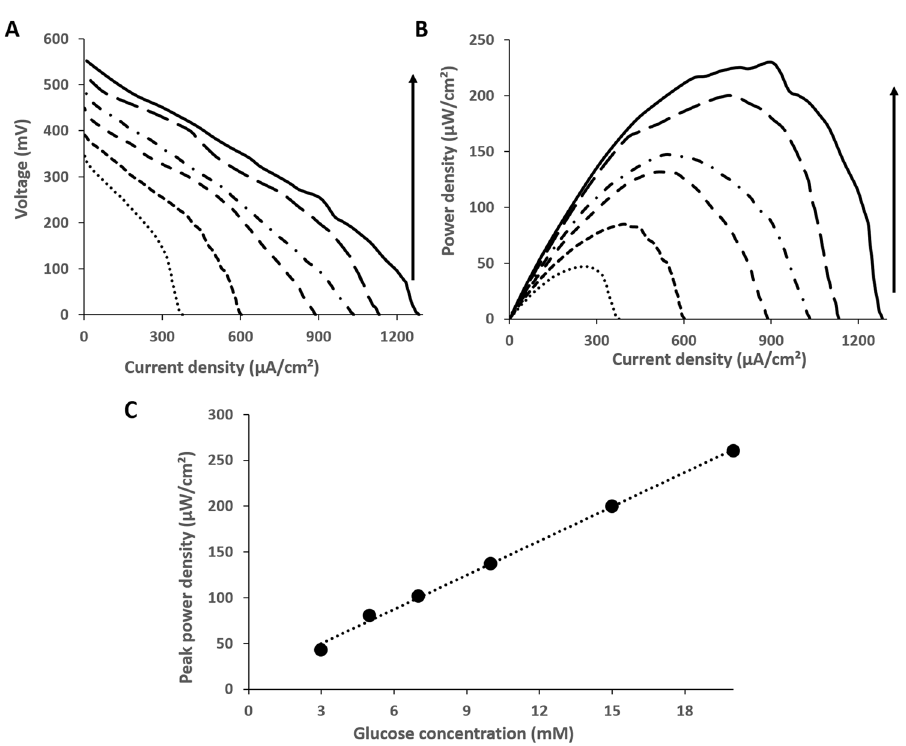
Figure 3. ( A ) Polarization characteristics of the enzymatic glucose biofuel cell composed of the PQQ-GDH modified buckypaper bioanode and the BOD modified buckypaper biocathode operating in increasing standard glucose solution (37 °C, pH 7.4 [3, 5, 7, 10, 15, 20 mM]); ( B ) The power curve as the functions of the current density; ( C ) Corresponding calibration curve of biofuel cell (peak power density vs. glucose concentration